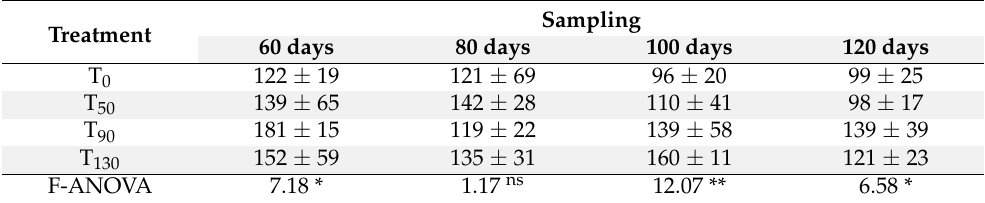
Table 5. Calcium content (mg/L) in leachates. Entries represent means ± standard errors from n = 3 replicates.